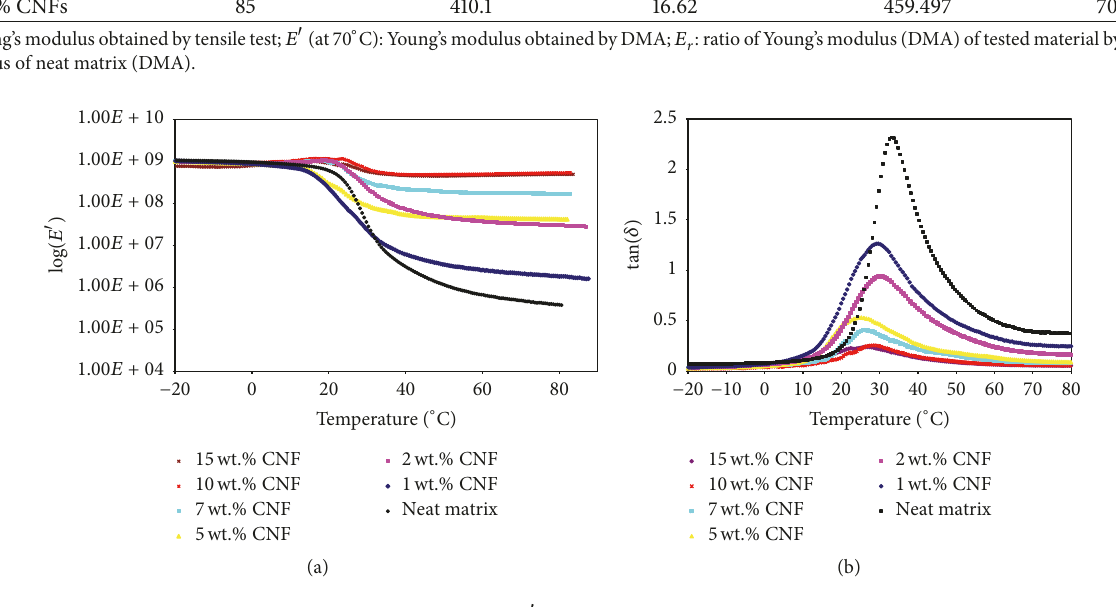
Figure 5: Evolution of (a) logarithm of storage tensile modulus 𝐸 󸀠 and (b) loss angle tan( 𝛿 ) versus temperature at 1Hz for nanocomposites based on CNFs derived from Prunus amygdalus